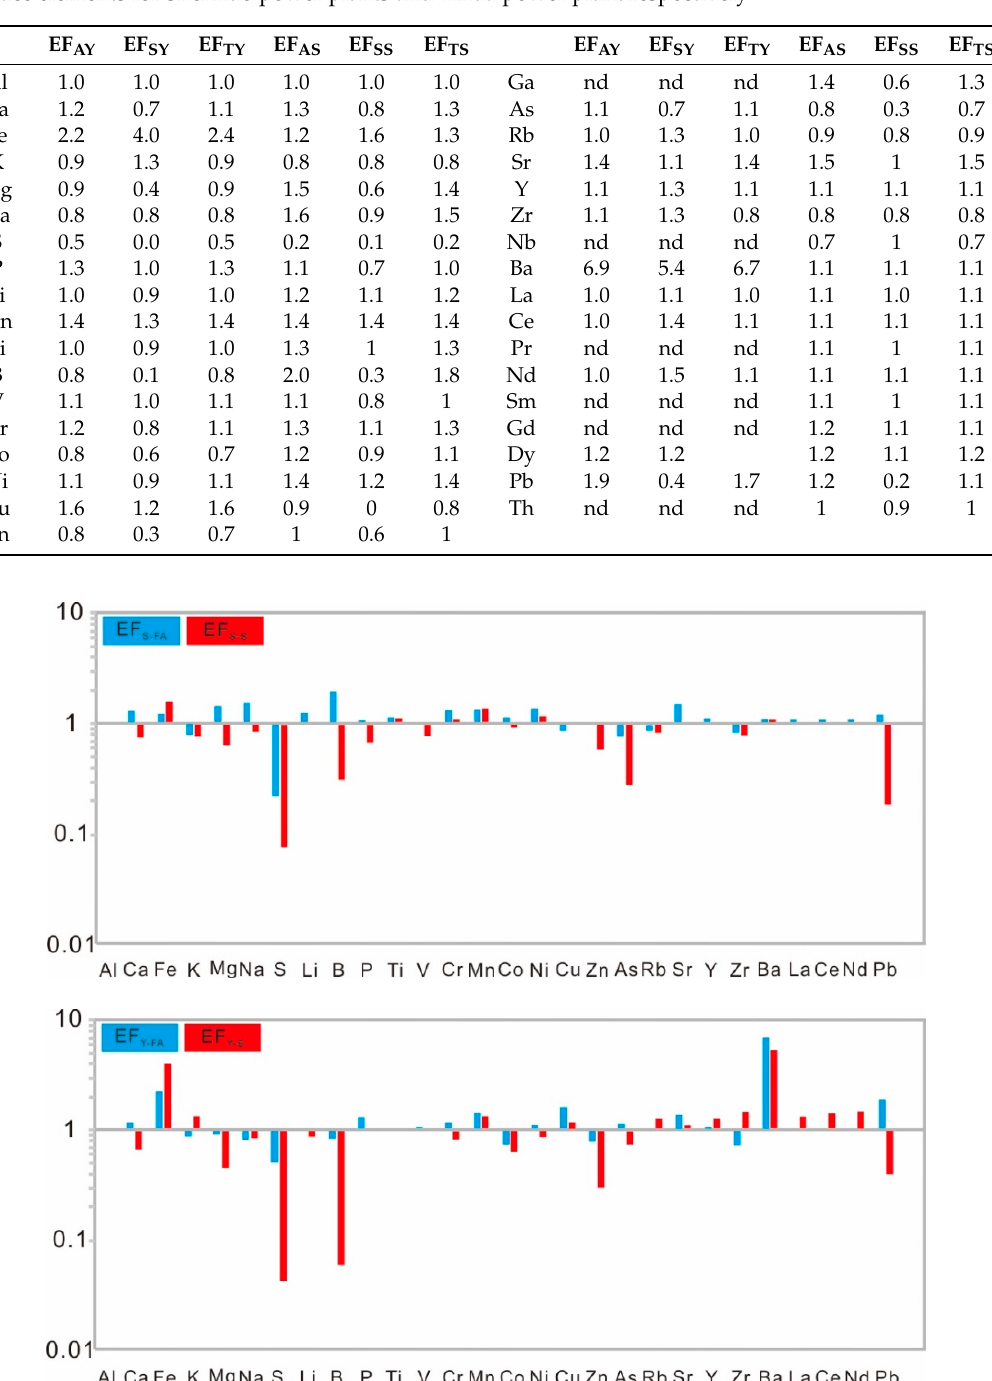
Figure 7. Enrichment factors for fly ash and slag from Shenhuo ( up ) and Yihua ( down ) power plants. EF S-FA , enrichment factor in fly ash from Shenhuo power plant; EF S-S , enrichment factor in slag from Shenhuo power plant; EF Y-FA , enrichment factor in fly ash from Yihua power plant; EF Y-S , enrichment factor in slag from Yihua power plant.